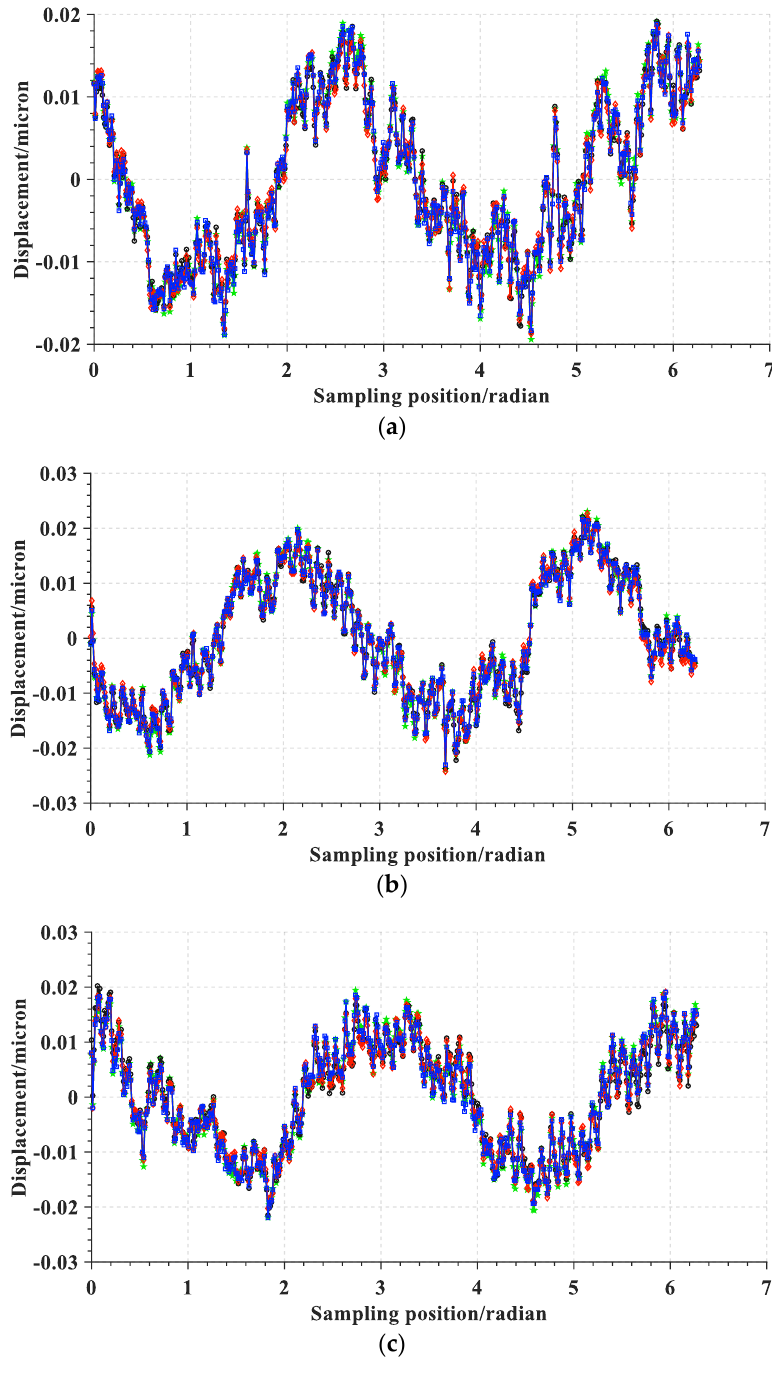
Figure 13. Amplitude phase diagrams of the multi-turn sampling data of the three sensors with the eccentricity and synchronization error removed in the Cartesian coordinate system: ( a ) data from sensor A, ( b ) data from sensor B, and ( c ) data from sensor C.